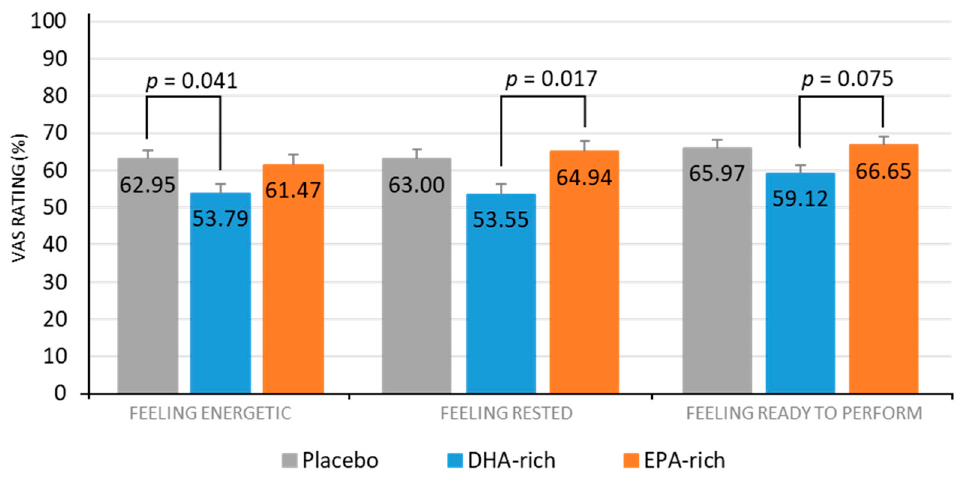
Figure 3. Estimated marginal means and standard error (SE) for post-treatment subjective ratings for feeling energetic, feeling rested, and feeling ready to perform, by treatment group.